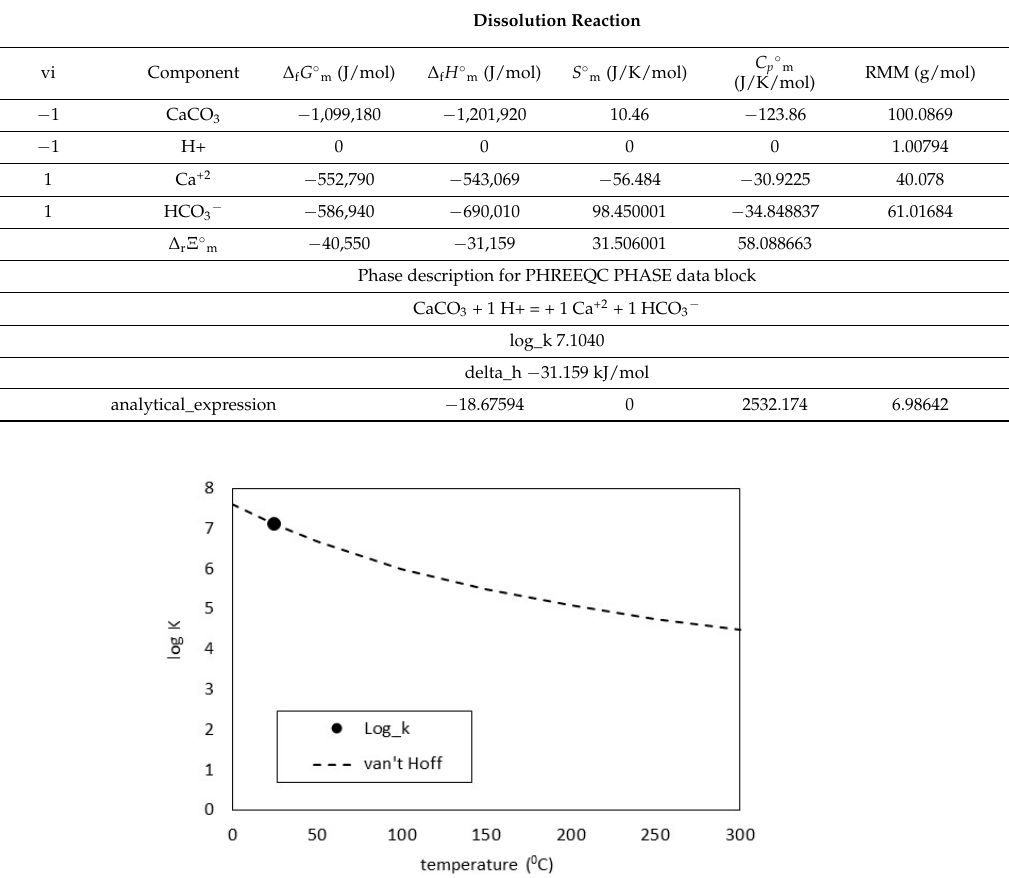
Figure 1. Vaterite log K comparisons.